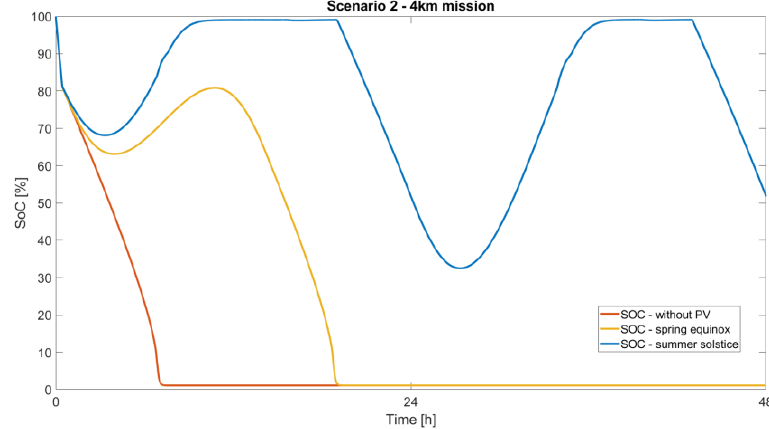
Figure 12. State of Charge of the battery during the continuous flight at 4 km.